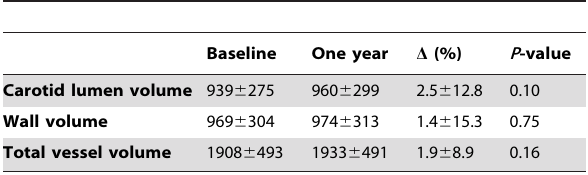
Table 1. Volumetric measurements (mm 3 ) at baseline and after one